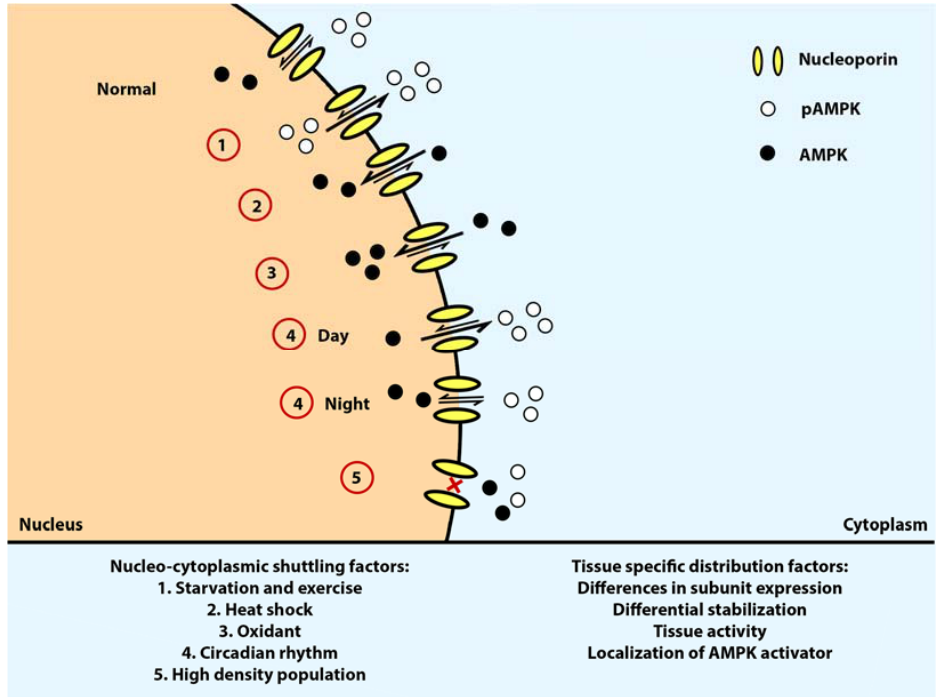
Figure 4. AMPK nucleo-cytoplasmic shuttling upon different stimulation. pAMPKs are more localized on the cytoplasm upon starvation, exercise, and during the day. Upon heat shock and oxidant exposure, AMPK undergoes nuclear localization in a dephosphorylated state. Arrow: distribution direction of total AMPK, white circle: Thr 172 phosphorylated AMPK, black circle: non phosphorylated AMPK, yellow channel: